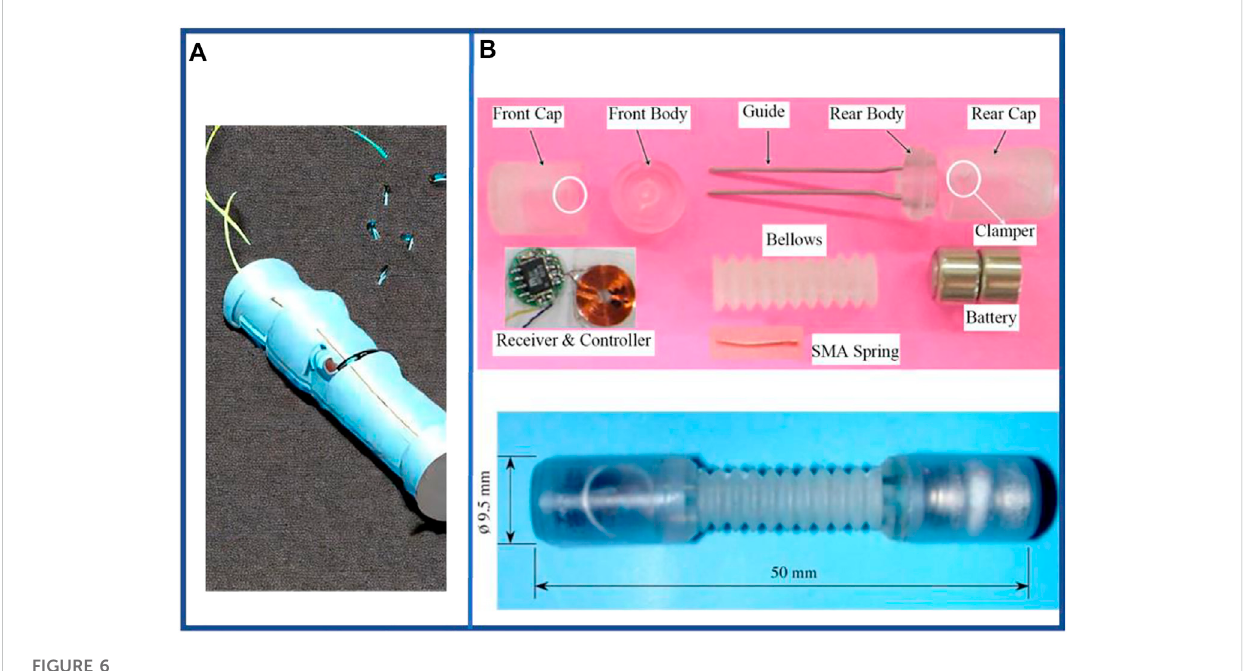
FIGURE 6 Examples of electric-driven single-segment earthworm-inspired soft robot. (A) Mini electric-driven earthworm-like robot used for capsule endoscopes. (B) Drawings ofcomponents and assembly of microrobotusing shape memory alloy actuator (Kimetal., 2006).Reproducedfrom Ref.(Kim et al., 2006). with permission.